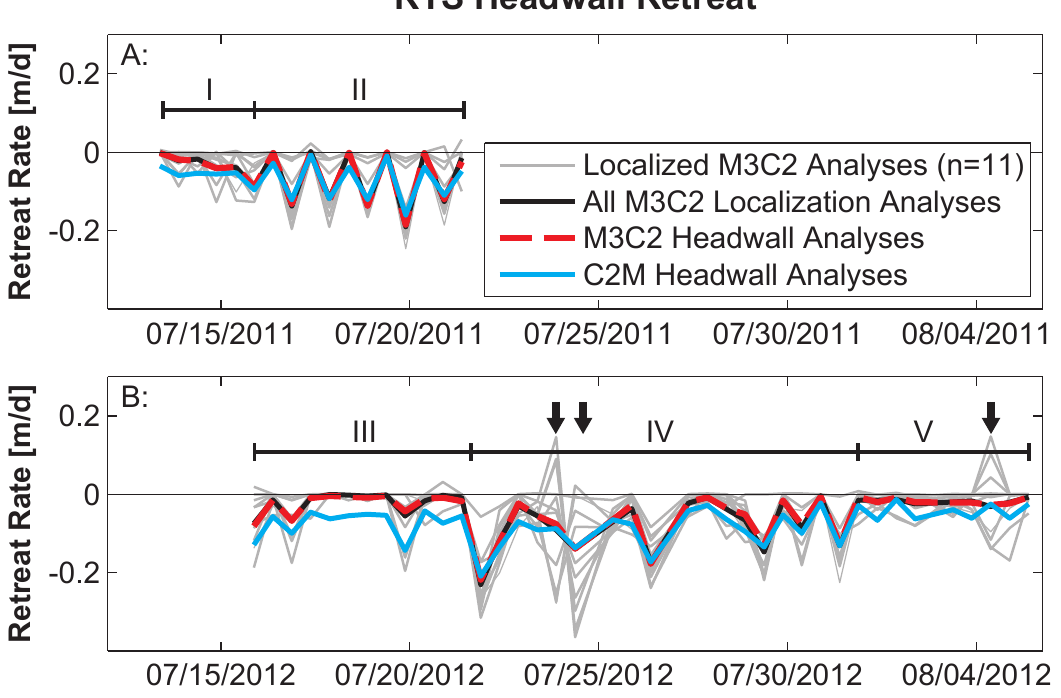
Figure 6. Comparison of C2M and M3C2 RTS headwall retreat rates and the localization analyses from Section 3.4. Negative values indicate retreat of the landform. In both 2011 ( A ) and 2012 ( B ), the C2M and M3C2 methods show similar patterns; however, during epochs of consistent low magnitude change (segments I, III, and V), the C2M technique overpredicts the RTS headwall retreat rate when compared to M3C2. How each technique identifies insignificant change is the root of this difference. Both M3C2 and C2M resolve a strong diel signal in 2011 (segment II) and a weaker diel signal in 2012 (segment IV). These differences are likely due to the general weather patterns observed in 2011 (clear and warm) and 2012 (cool, wet and cloudy). The localization analyses (Figure 3(D)) show that individual areas on the headwall cannot always approximate the overall retreat rate of the entire